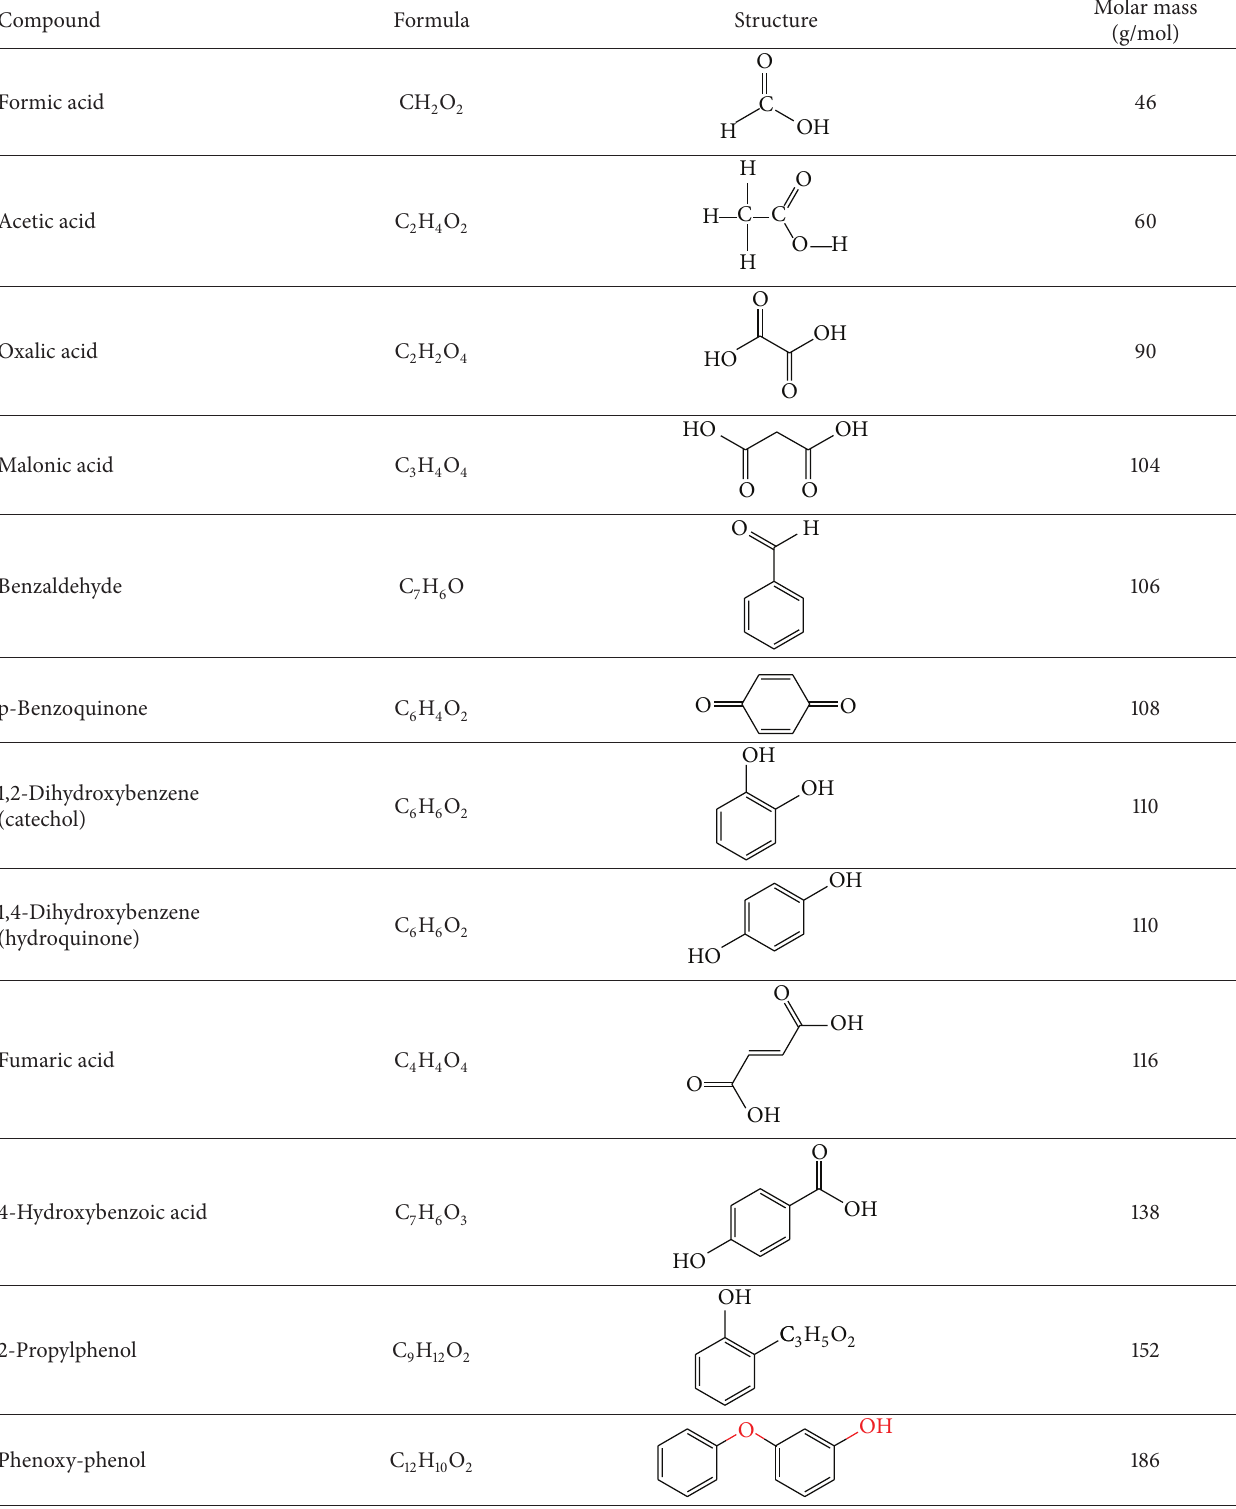
Table 3: Identified compounds by